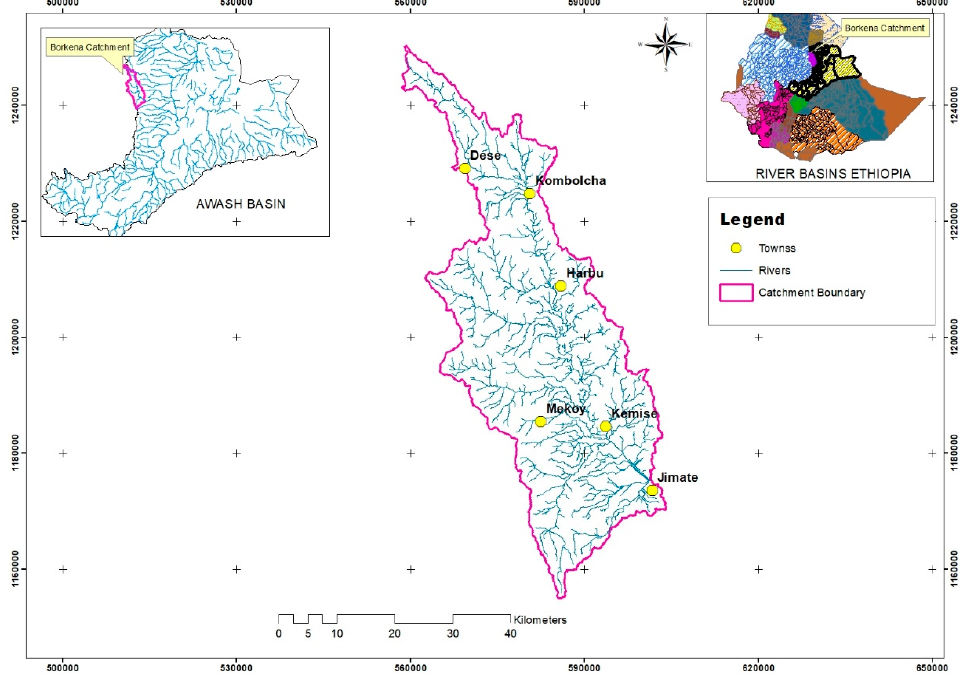
Figure 2. A hydrogeological map of the study area produced (data source: ECDSWC-WEDSWS).